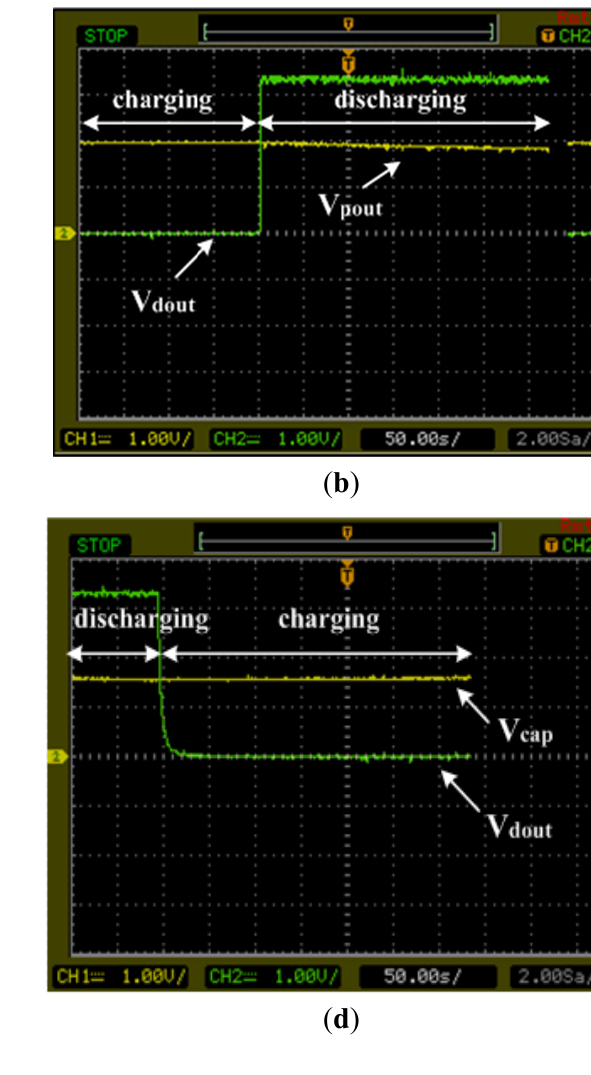
and V from charging to discharging; ( c ) V pout dout